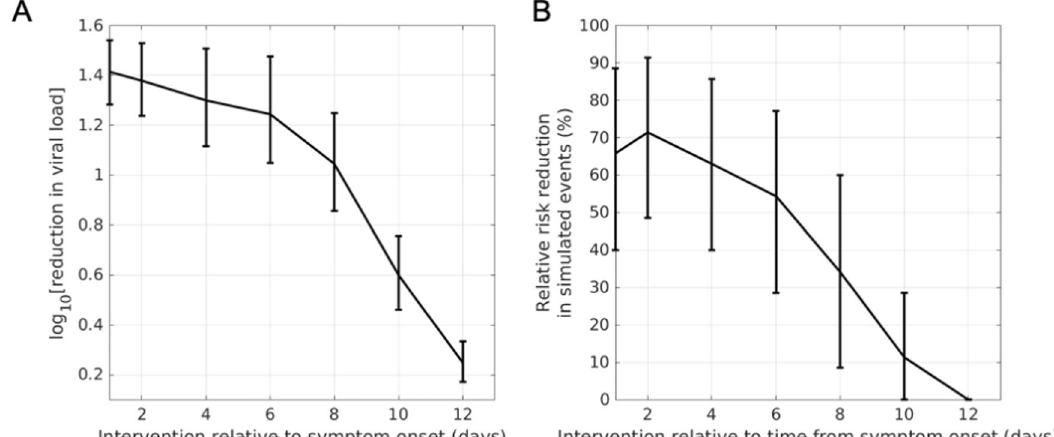
Fig. 6 Model predicted attenuation of relative risk reduction with increasing time of intervention initiation relative to symptom onset. Sensitivity of ( A ) viral load-lowering ef fi cacy and ( B ) disease severity reduction to the time of intervention for the simulated 2800 mg bamlanivimab + 2800 mg etesevimab treatment and Blaze-1 Ph3 virtual population. The model predicts that early intervention when closer to peak viral load (symptom onset) results in greater viral load-lowering ef fi cacy and relative risk reduction in severity endpoint. Error bars indicate 99% prediction intervals of